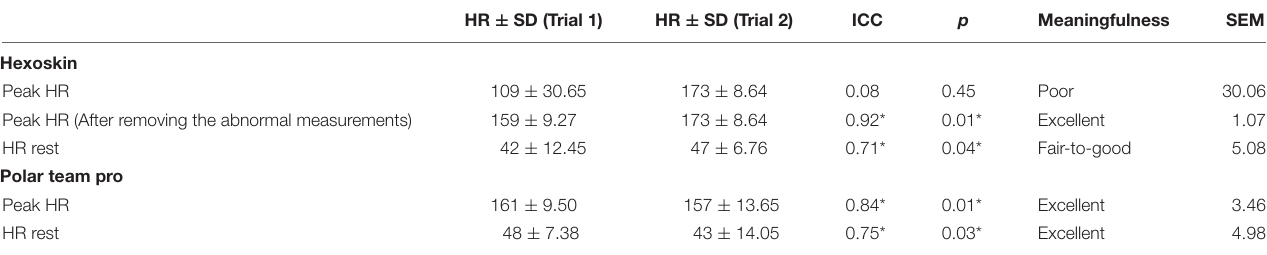
TABLE 2 | Reliability of Hexoskin and Polar Team Pro